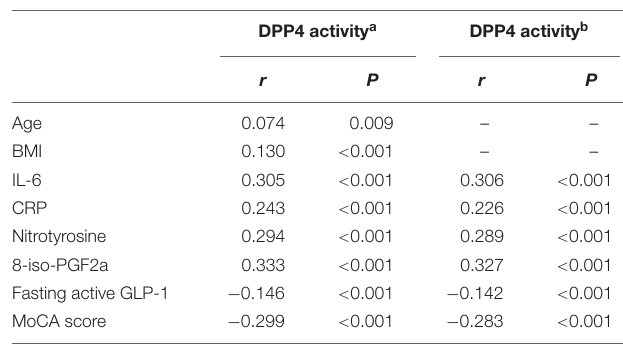
TABLE 3 | Correlations between DPP4 activities vs metabolic parameters and MoCA